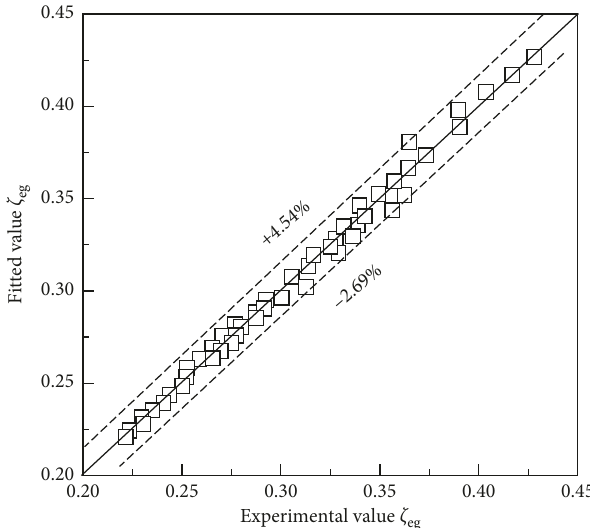
Figure 8: Comparison of local pressure loss coefficient (only airflow) between the experimental values and the fitted values.